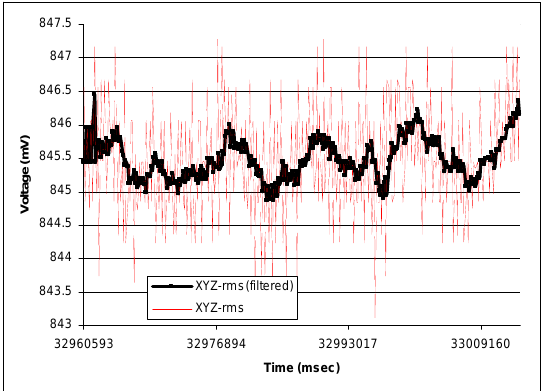
Figure 11. Calculated rms when the accelerometer is stationary with and without the smoothing